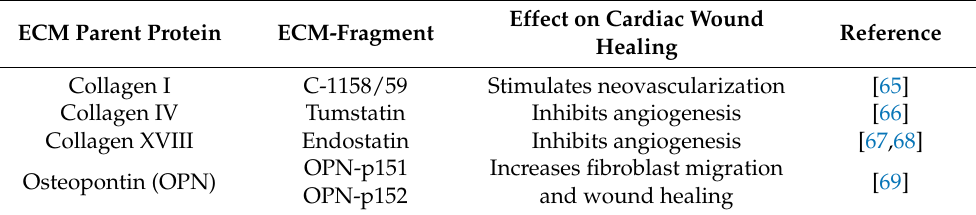
Selection of myocardial infarction relevant matrix metalloproteinase 9 (MMP-9) derived